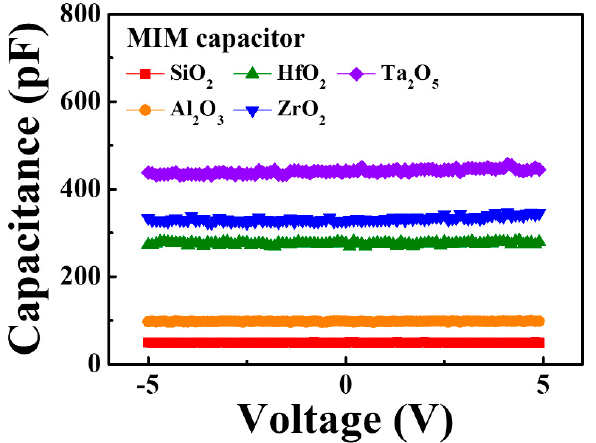
Figure 6. C-V characteristic curves of metal–insulator–metal (MIM) capacitor with various gate dielectrics.